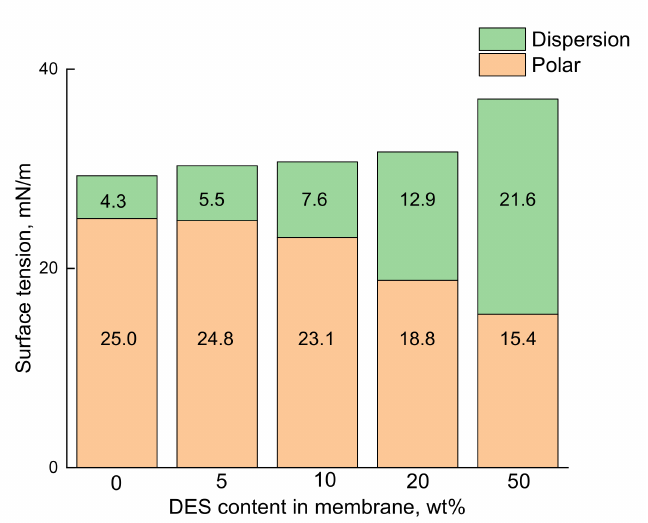
Figure 6. Dependence of the surface tension on DES content in the Torlon/DES